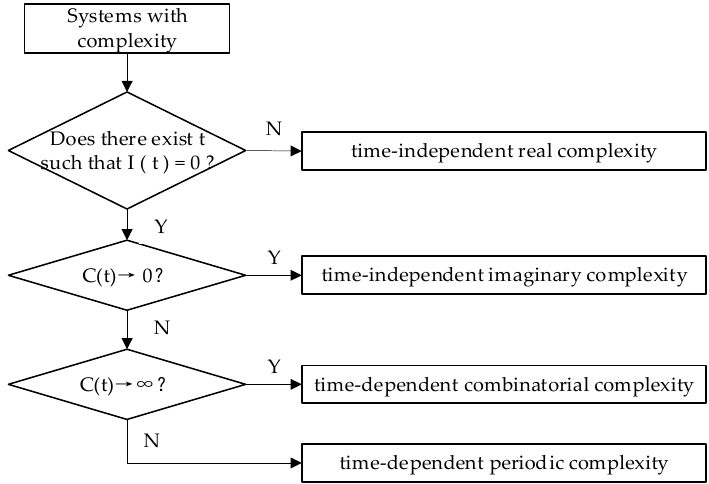
Figure 4. The system complexity determination process.